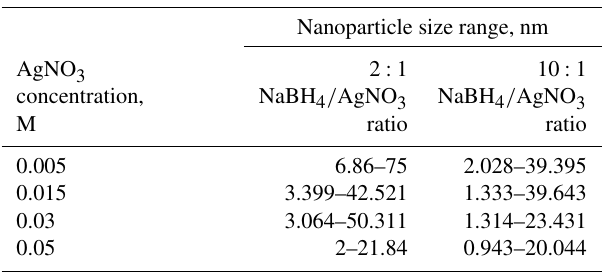
ify. The dehydrated medium was homogeneous, free-flowing and beige in color.